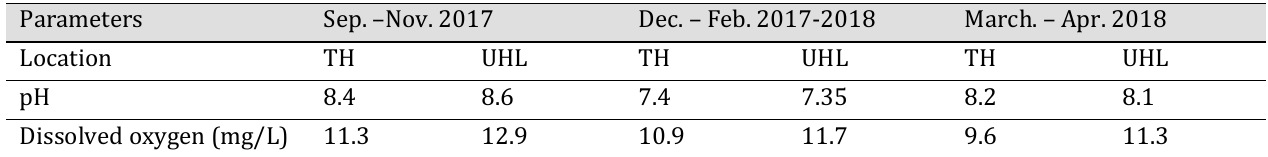
Table 1. Parameters of water of Tubruk Harbor and Umm Hufayan lagoon